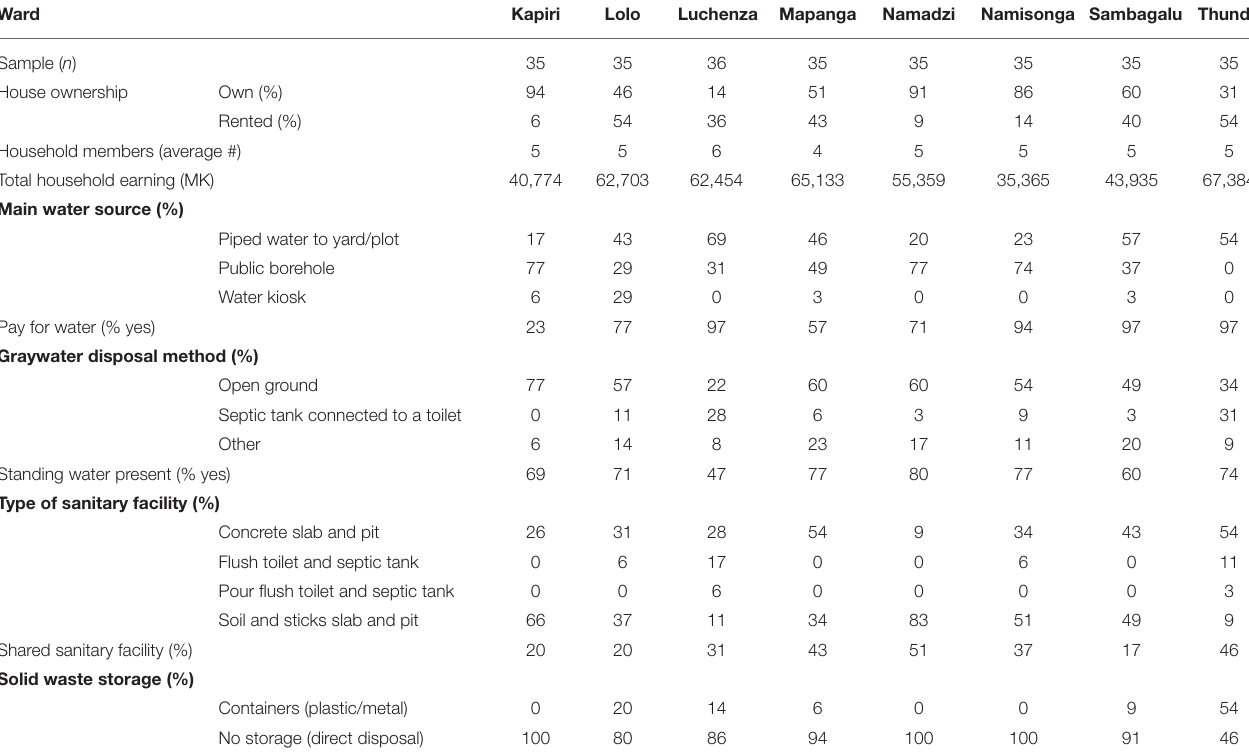
TABLE 1 | Selected* environmental indicators across wards.